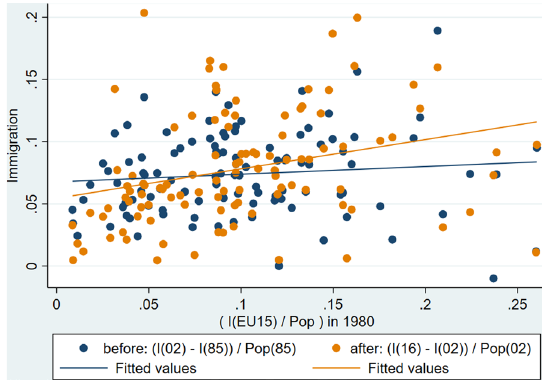
Fig. 2 Immigration before and after the AFMP reform as a function of the share of EU-15 immigrants in 1980. Notes: Each dot represents a MS-region. The y-axis displays the change in the stock of foreigners between years 2002 and 1985 relative to total population in 1985 (blue dots) and the change in the stock of foreigners between years 2016 and 2002 relative to total population in 2002 (orange dots). Source: Own calculations based on data from Federal Statistical Office